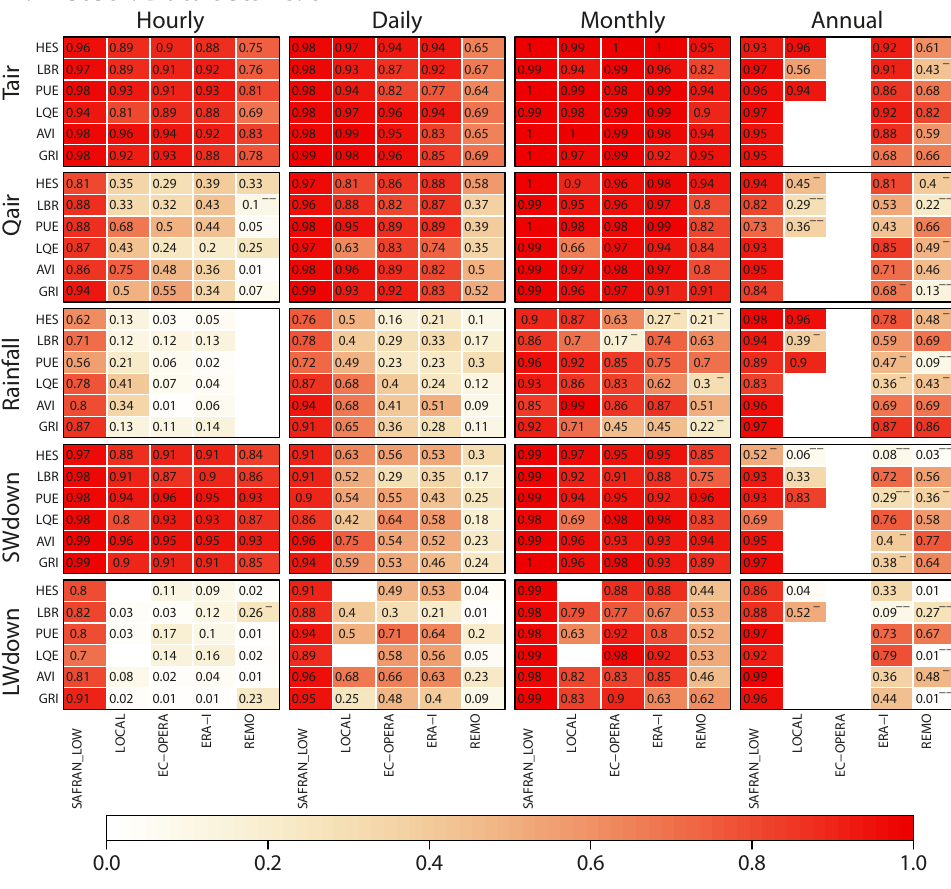
Fig. B2. Squared correlation ( R 2 ) between meteorological data sets and SAFRAN over 2004 to 2007, except for EC-OPERA which covers 2004–2006. Panels of R 2 from left to right are for hourly, daily, monthly and annual time scales, respectively. Time series used to calculate R 2 correspond to growing season (GS). See text Sect. 2.1 for the definiton of GS. The default statistical confidence level of R 2 is p < 0 . 01. Otherwise, the signal “–” at the upright indicates a confidence level of p < 0 . 05 and “– –” for p > 0 .